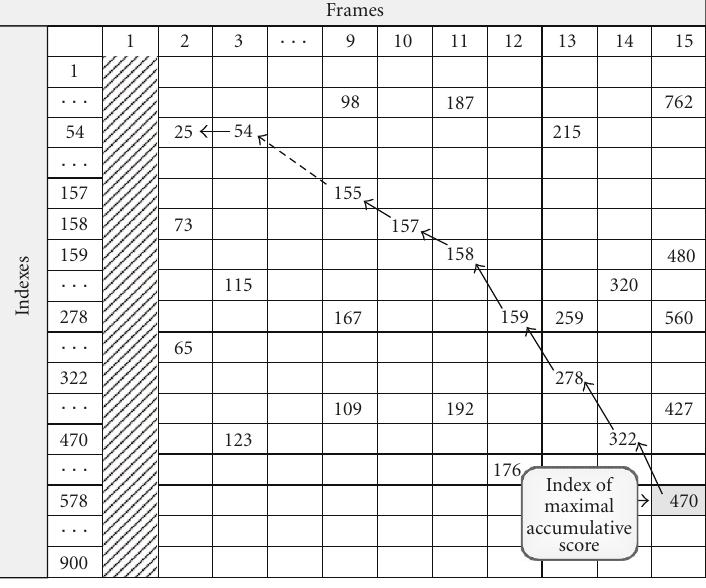
Figure 5: Example of a tracking matrix, and the “target” track. Table 1: The various real IR sequences used for the testing.